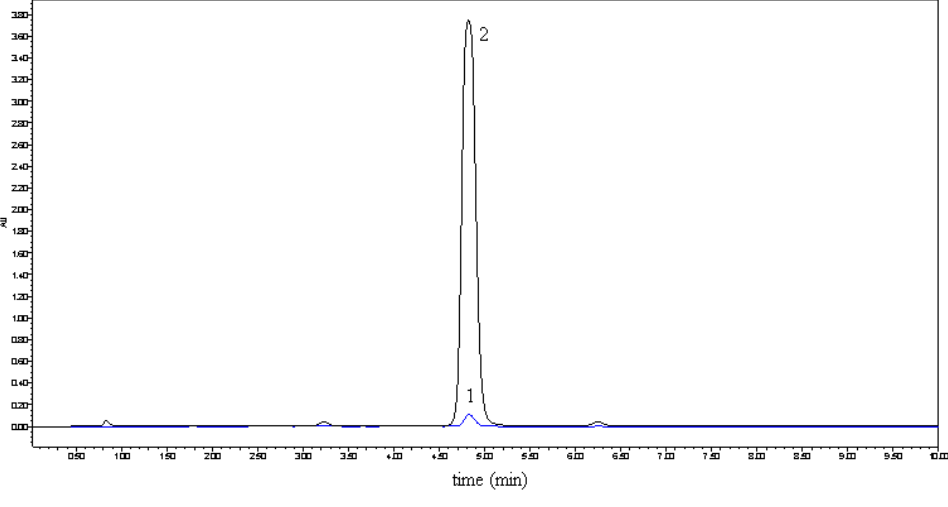
Figure 1. Solubility comparison of naringenin ( 1 ) and its complex 2 in